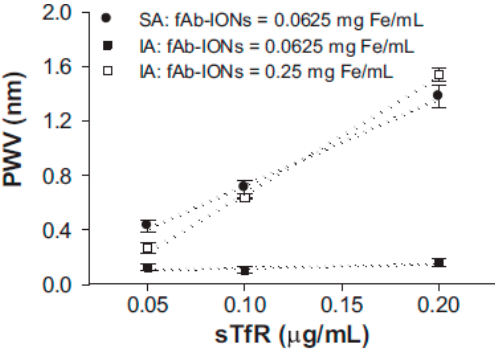
Figure 18. The schematic illustration of the fabrication of Ag-SPCBs (silver nanoshells silica photonic crystal beads) ( A ); and the multiplex SERS bioassay ( B ). Reproduced with permission from [43].